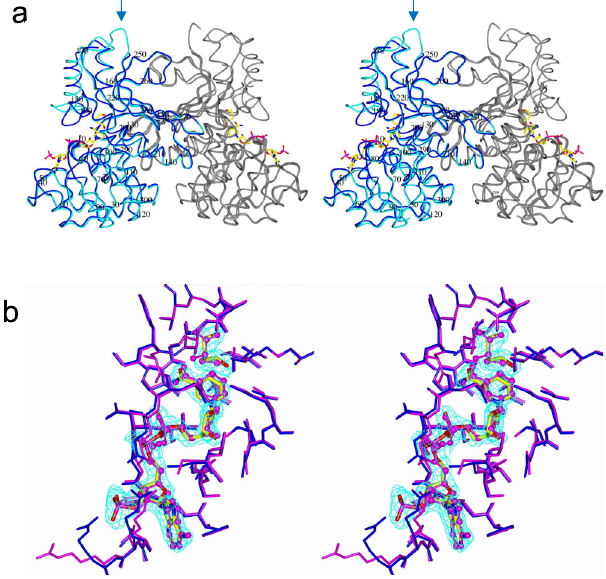
Fig. 1 The IM and IM/NADP/BU structures in their physiological dimeric form. a The IM and IM/NADP/BU structures are shown in cyan and blue, respectively, with the other subunit in gray. NADP + atoms are shown as cylinders. The arrow indicates a disordered part (227 – 231 aa). b The substrate-binding pockets of the IM/NADP/BU and M/NAD/Cys structures are shown in blue and pink, respectively. NADP + and BU are shown as cylinders, while NAD + and Cys are shown as ball and stick. The 2Fo – Fc electron density in the map is contoured at the + 1.0 sigma